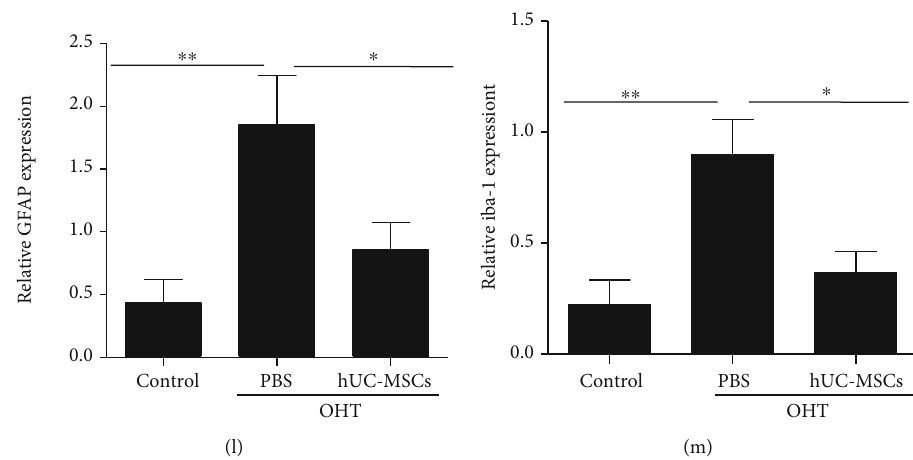
Figure 5: hUC-MSC transplantation decreases GFAP, iba-1, and TLR4 expression in the retinas of OHT-induced rats. Two weeks after hUC-MSC injection. (a – c) TLR4 immunohistochemistry staining from normal eyes, OHT+PBS eyes, and OHT+hUC-MSC eyes; (d – f) ampli fi cation of the corresponding groups. The arrow indicates positive TLR4 staining. (g) Quanti fi cation of TLR4 staining in retinas ( n = 4/group ; ∗ P < 0 : 05 and ∗∗ P < 0 : 01 compared with one-way ANOVA with Turkey ’ s post hoc tests). (h) Relative TLR4 gene expression that was normalized to GAPDH in retinas from normal eyes, OHT+PBS eyes, and OHT+hUC-MSC eyes ( n = 4/group ; ∗∗∗ P < 0 : 001 compared with one-way ANOVA with Turkey ’ s post hoc tests). (i) Western blot analysis for TLR4 protein from normal eyes, OHT+PBS eyes, and OHT+hUC-MSC eyes. (j) Relative TLR4 protein expression that was normalized to GAPDH ( n = 4/group ; ∗ P < 0 : 05 and ∗∗ P < 0 : 01 compared with one-way ANOVA with Turkey ’ s post hoc tests). (k) Western blot analysis of GFAP and iba-1 protein from normal eyes, OHT+PBS eyes, and OHT+hUC-MSC eyes. (l and m) Relative GFAP and iba-1 protein expression that was normalized to GAPDH ( n = 4/group ; ∗ P < 0 : 05 and ∗∗ P < 0 : 01 compared with one-way ANOVA with Turkey ’ s post hoc tests). Scale bar: 100 μ